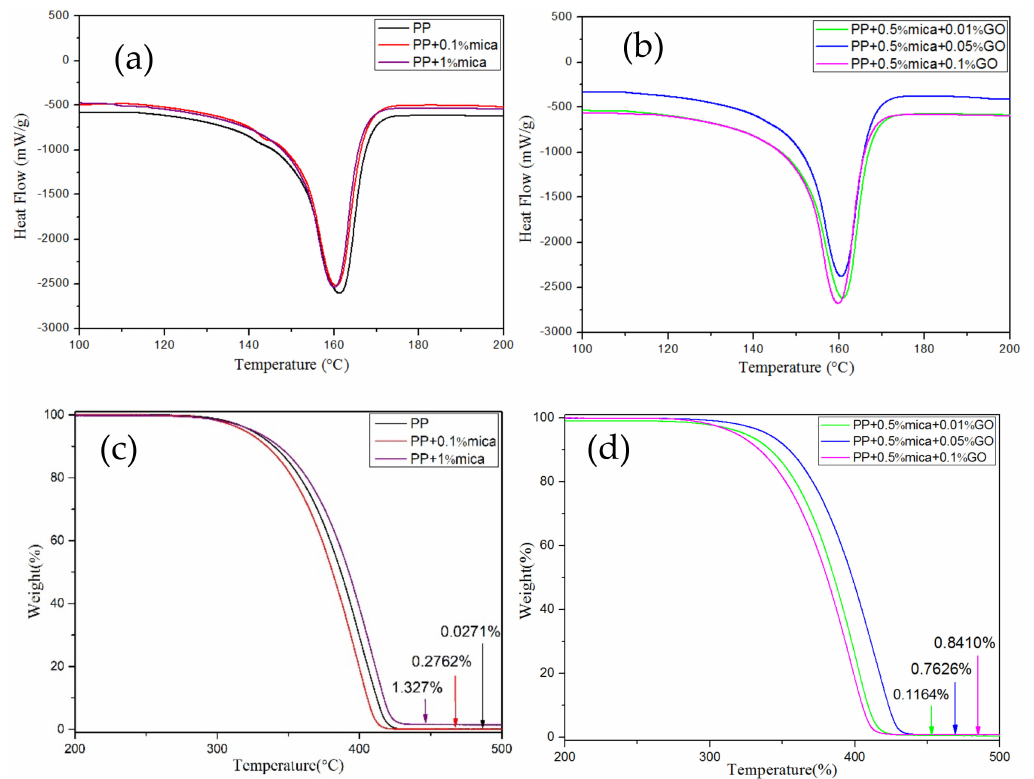
Figure 7. Differential scanning calorimetry (DSC) heating curves of ( a ) polypropylene (PP) and the PP/mica composites. ( b ) PP/mica/graphene oxide composites. And Thermogravimetric analysis (TGA) curves of ( c ) polypropylene (PP) and the PP/mica composites. ( d ) PP/mica/graphene oxide composites.